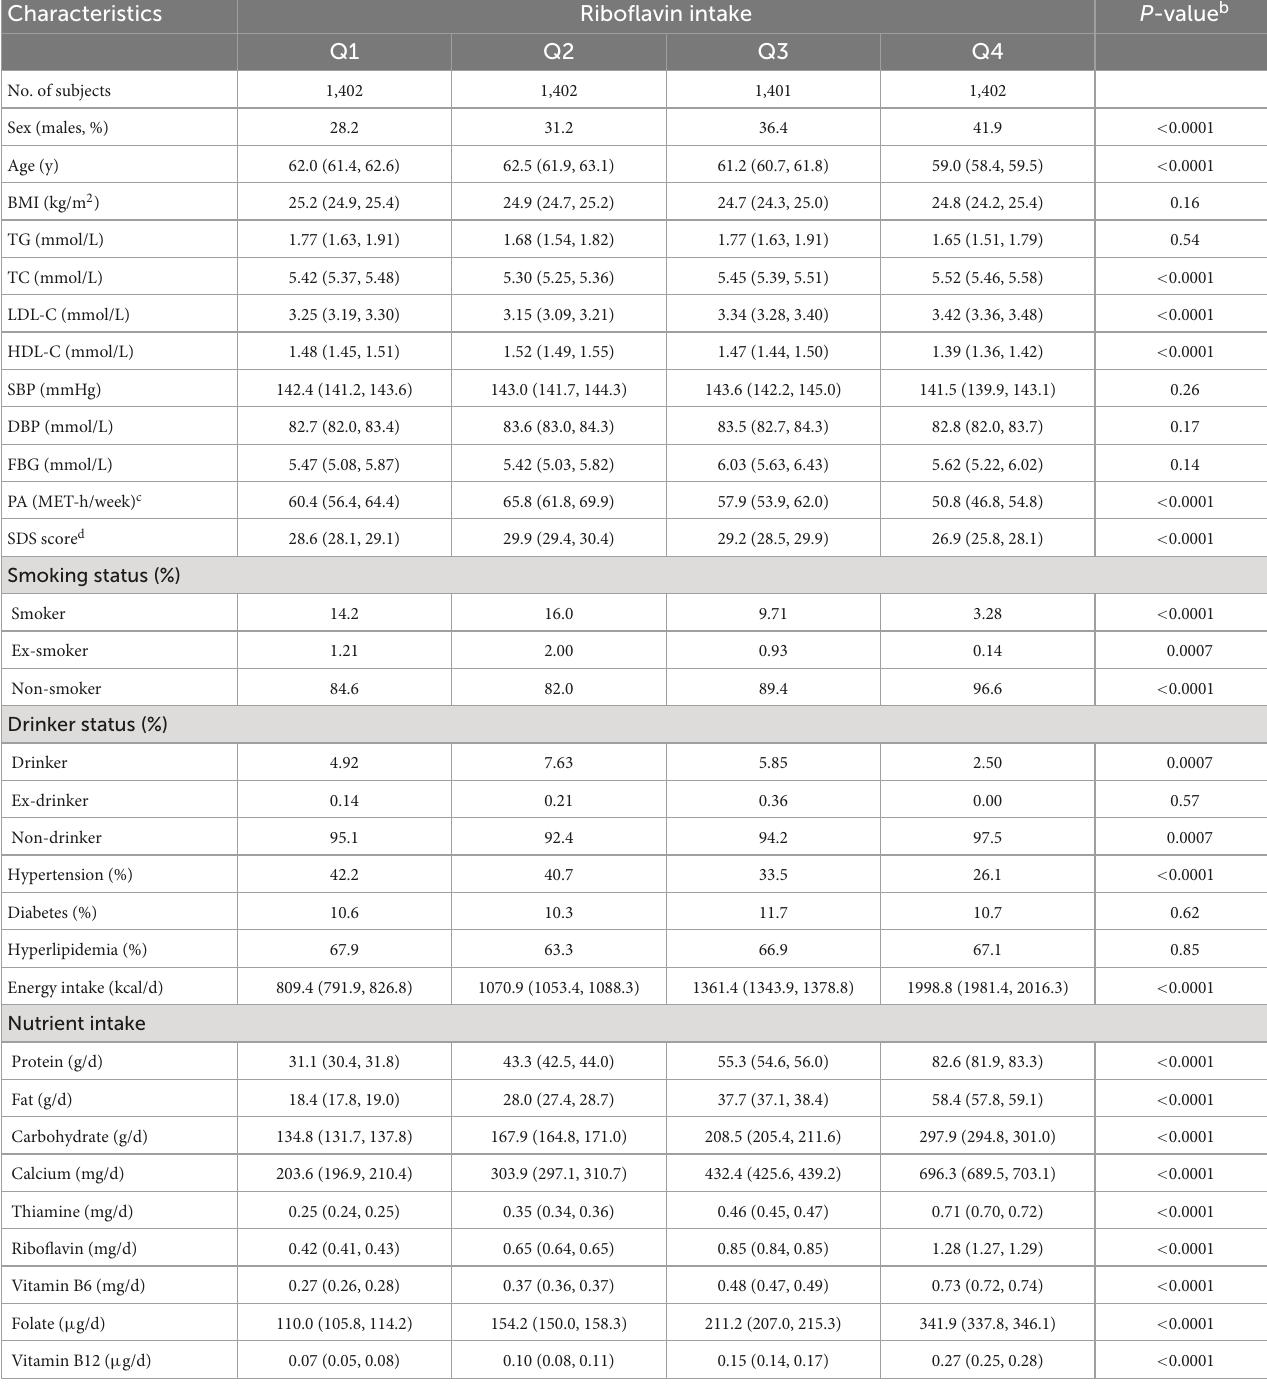
TABLE 2 Characteristics of the participants by riboflavin intake a ( n = 5,607).